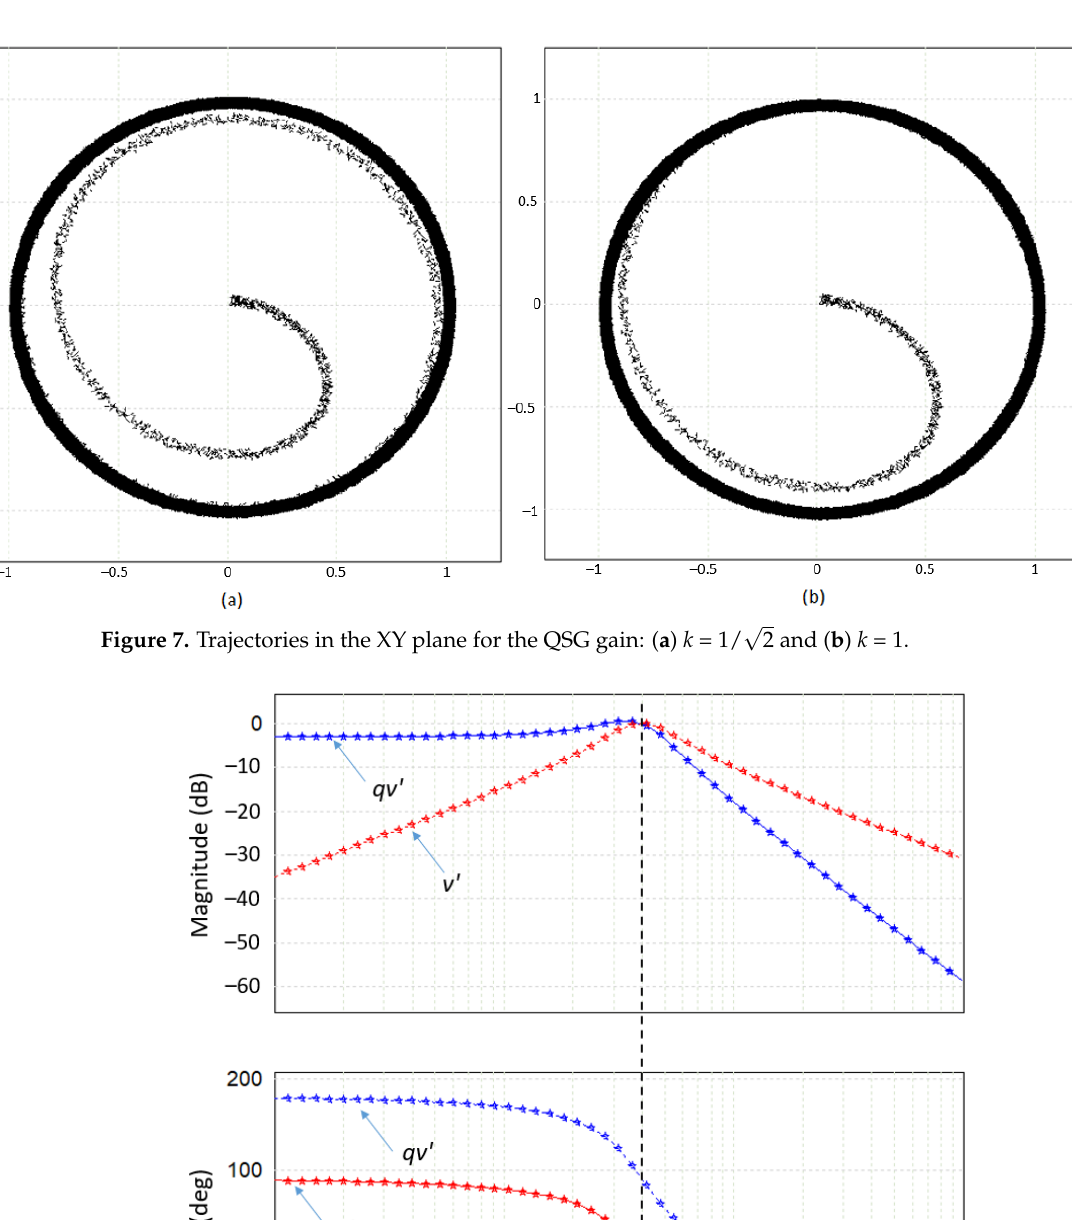
Energies 2021 , 14 , x FOR PEER REVIEW 10 of 19